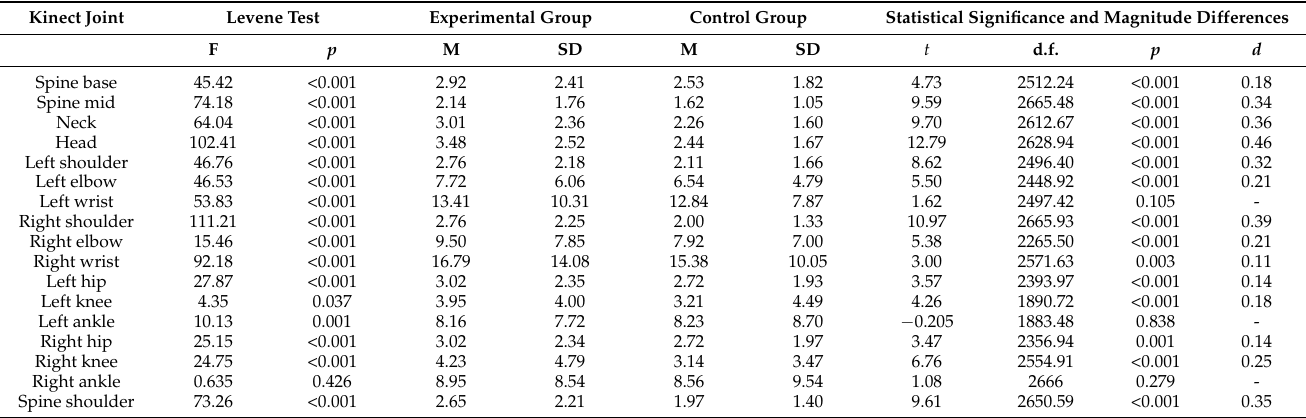
Table 3. Differences in means of movement of the different joints recorded by Kinect between the experimental group and the control group. Kinect Joint Levene Test Experimental Group Control Group Statistical Significance and Magnitude